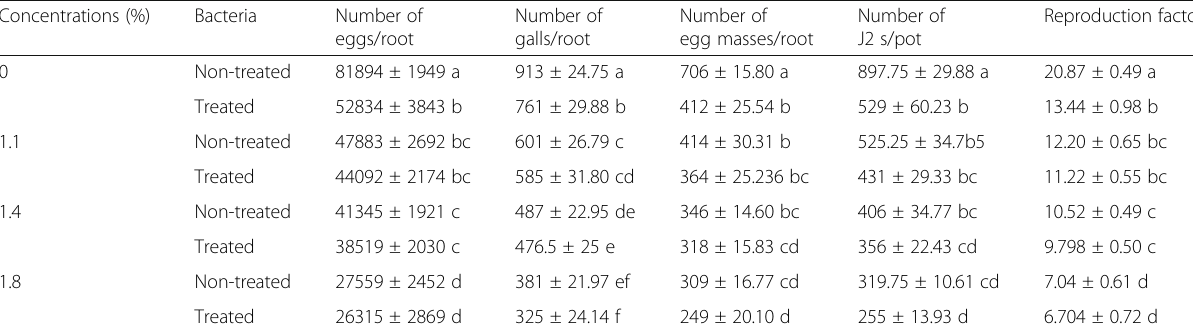
Table 5 Mean numbers of galls, egg masses and eggs per root, second-stage juveniles (J 2 s) per pot, and reproductive factor (RF) of Meloidogyne javanica after nematode inoculation along with Pseudomonas fluorescens CHA0 incubation of tomato plants and different concentrations of Datura stramonium treated in trials I and II Concentrations